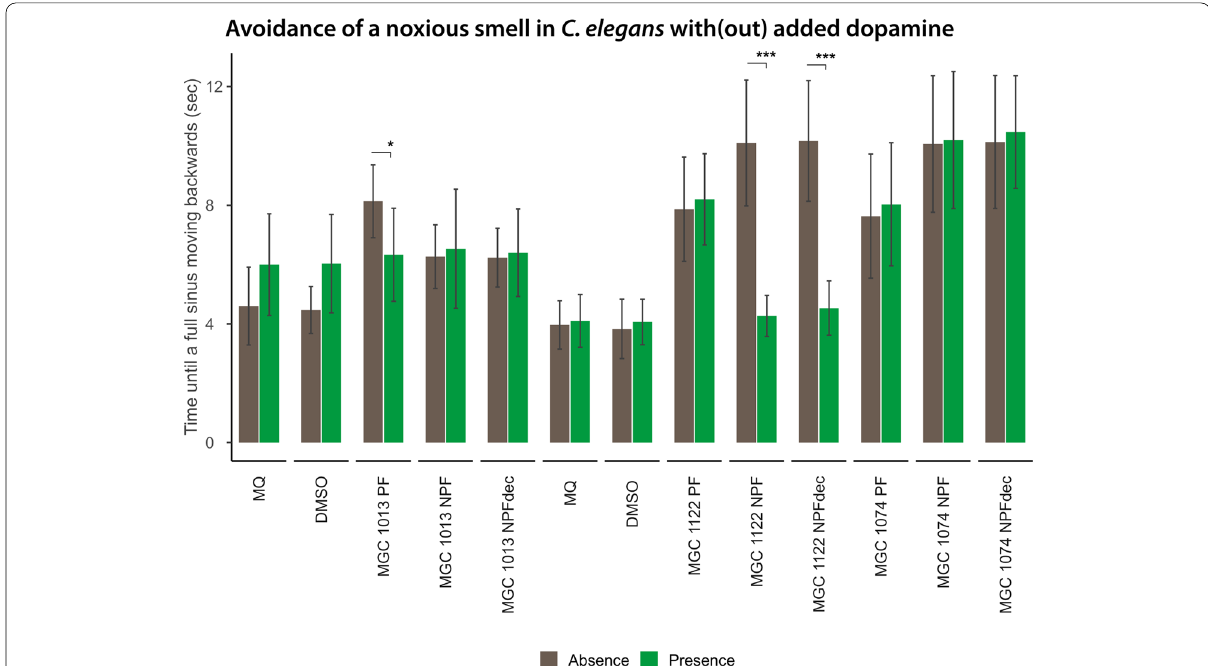
Fig. 7 Influence of cannabis fractions on dopamine as mechanism to regulate the avoidance behavior towards 1‑octanol. Effects of nematode treatment with the 100 μg/mL of the polar fractions (PFs) of the cannabidiol (CBD)‑rich cannabis varieties MGC 1013, MGC 1074, and MGC 1122 on the avoidance of 1‑octanol in the presence (green bars) or absence (brown bars) of added dopamine. Nematode treatment with the 100 μg/mL PF of MGC 1013 as well as treatment with a non‑toxic dose of 5 μg/mL of the non‑polar fraction (NPF) of MGC 1122 alleviates the delayed response to 1‑octanol induced by the treatment, suggesting that treatment leads to reduced levels of dopamine and thereby to delayed responsiveness towards aversive 1‑octanol. MQ indicates the Milli‑Q water control group, DMSO (dimethyl sulfoxide) the vehicle control. Mann‑Whitney U tests were used to compare each condition without added dopamine to the same condition with added dopamine. *** (FDR)‑corrected p < .001; * FDR‑corrected p < =